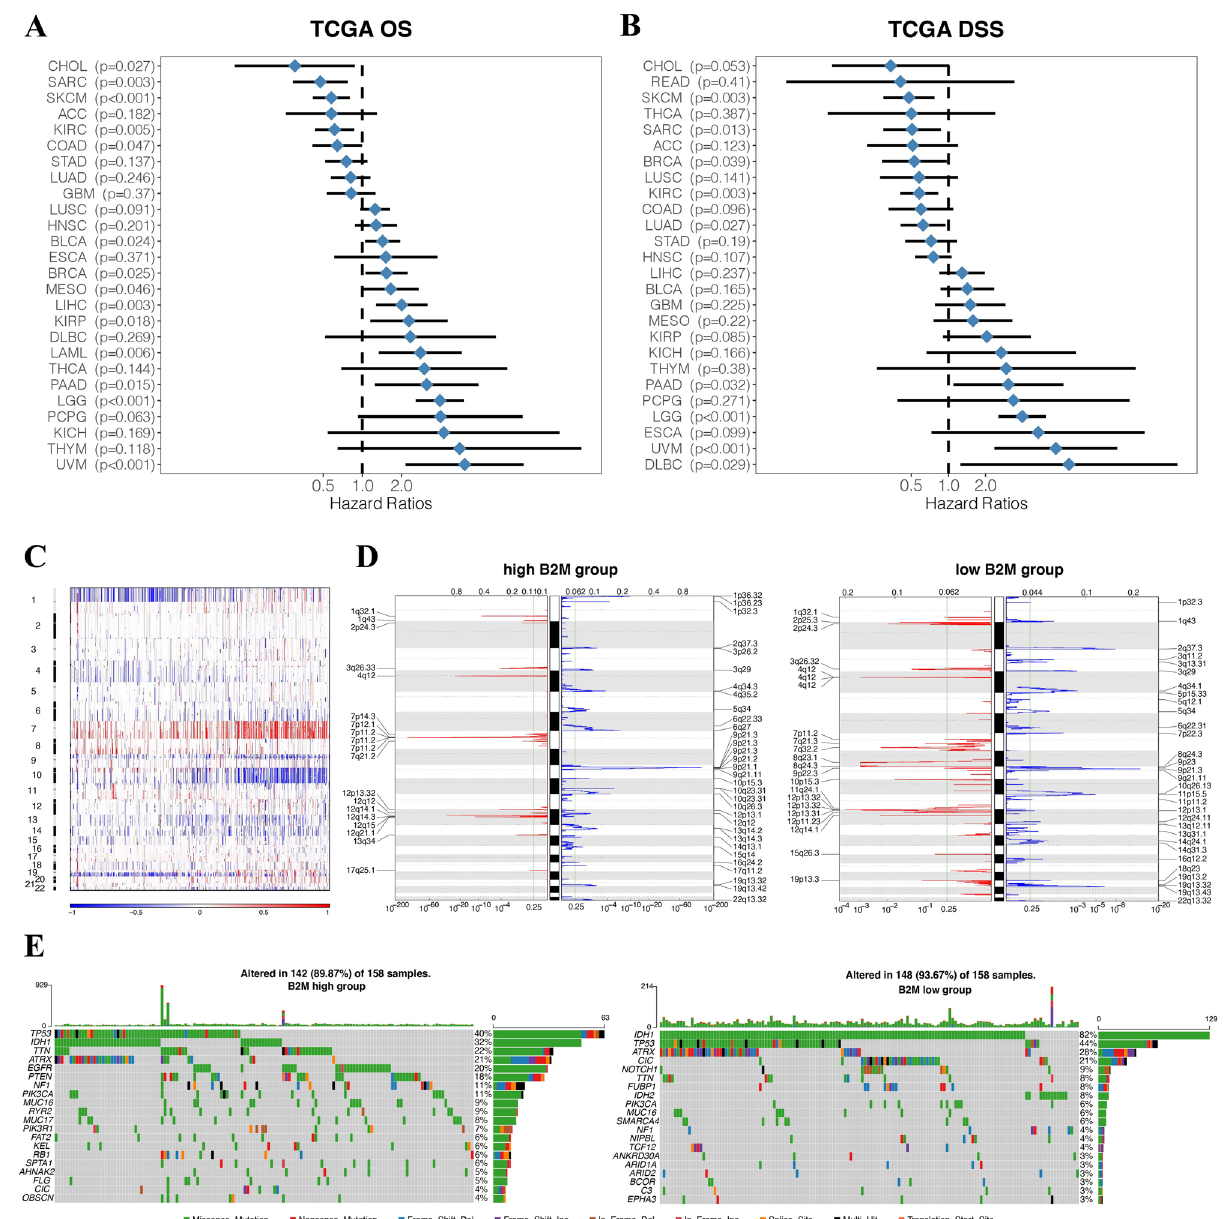
Figure 3. Distinct genomic profiles correlated with B2M expression. Univariate cox regression analyses estimating prognostic value of B2M in OS ( A ) and DSS ( B ) in different cancer types from TCGA. The length of horizontal line represents the 95% confidence interval for each group. The vertical dotted line represents the HR of all patients. HR < 1.0 indicates that high TME score is a favorable prognostic biomarker. Number of patients is indicated. TGCT testicular germ cell tumors, THYM thymoma, UVM uveal melanoma, READ rectum adenocarcinoma, LGG brain lower grade glioma, PAAD pancreatic adenocarcinoma, KICH kidney chromophobe, LUSC lung squamous cell carcinoma, ESCA esophageal carcinoma, STAD stomach adenocarcinoma, LUAD lung adenocarcinoma, GBM glioblastoma multiforme, HNSC head and neck squamous cell carcinoma, OV ovarian serous cystadenocarcinoma, BRCA breast invasive carcinoma, COAD colon adenocarcinoma, LIHC liver hepatocellular carcinoma, BLCA bladder urothelial carcinoma, UCEC uterine corpus endometrial carcinoma, KIRC kidney renal clear cell carcinoma, LAML acute myeloid leukemia, KIRP kidney renal papillary cell carcinoma, SARC sarcoma, CESC cervical squamous cell carcinoma and endocervical adenocarcinoma, MESO mesothelioma, SKCM skin cutaneous melanoma, UCS uterine carcinosarcoma, CHOL cholangiocarcinoma, PRAD prostate adenocarcinoma, DLBC lymphoid neoplasm diffuse large B-cell lymphoma, THCA thyroid carcinoma, PCPG pheochromocytoma and paraganglioma. P-values were obtained from the log-rank test. ( C ) The overall CNAs profile arranged by high and low B2M expression. Blue (deletion); red (amplification). ( D ) Frequency of amplifications and deletions generated by GISTIC2.0 analysis and stratified by B2M expression in gliomas. Deletion is blue and amplification is red. ( E ) Distinct somatic mutations in